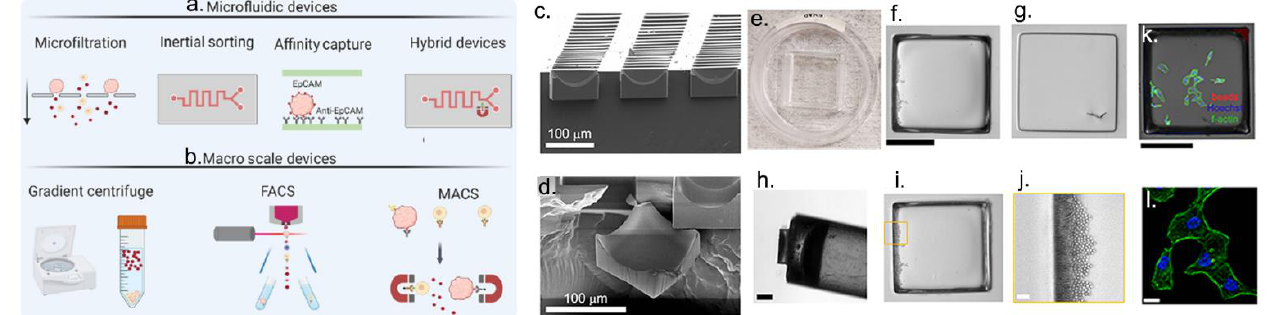
Figure 1. Single-cell separation, sorting and collection ( a ) micro- and ( b ) macro-technologies. Reprinted from Ref. [49] with permission from Elsevier. ( c ) Example of a microarray device. Embedded microstructures arrays (EMAs): scanning electron microscopy cross-section images of a full array ( c ) and one microcarrier ( d ). ( e ) Transparent EMA glued to the cassette where cells will be seeded. ( f − j ) Since iron oxide microbeads were embedded into each microcarrier, magnetic collections were performed by a microwand to isolate cells and release them into a different container. ( k , l ) High-quality images of cancer cells on EMAs. Black scale bars: 250 µm; white scale bars: 20 µm. Adapted with permission from Ref. [37] . Copyright 2022, Creative Common CC BY.